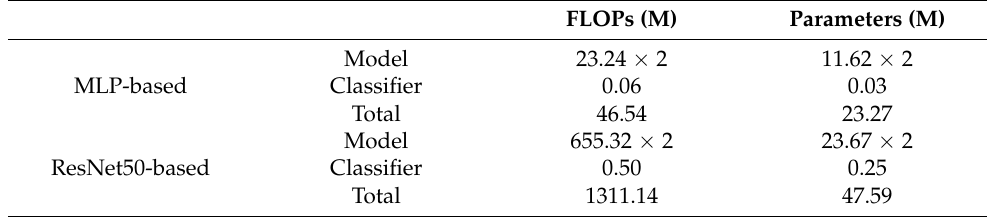
Table 9. Computational complexity and parameters